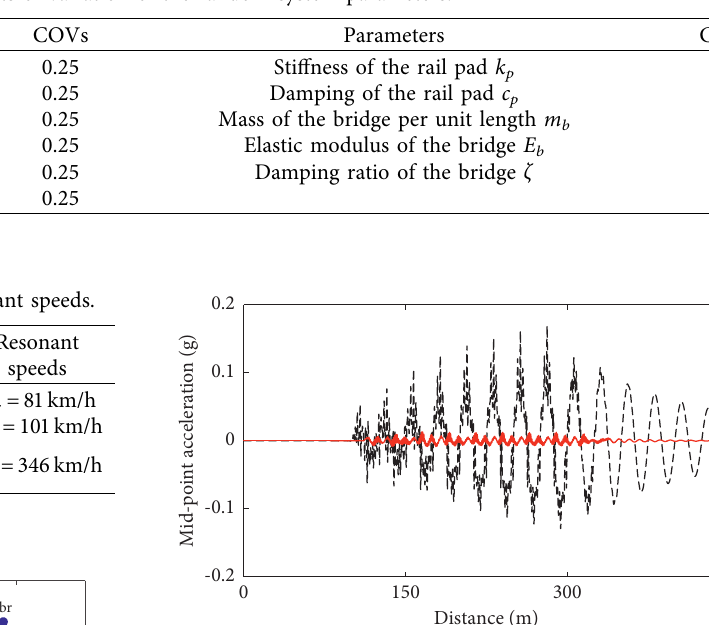
Table 2: Coefficients of variation of the random system parameters.